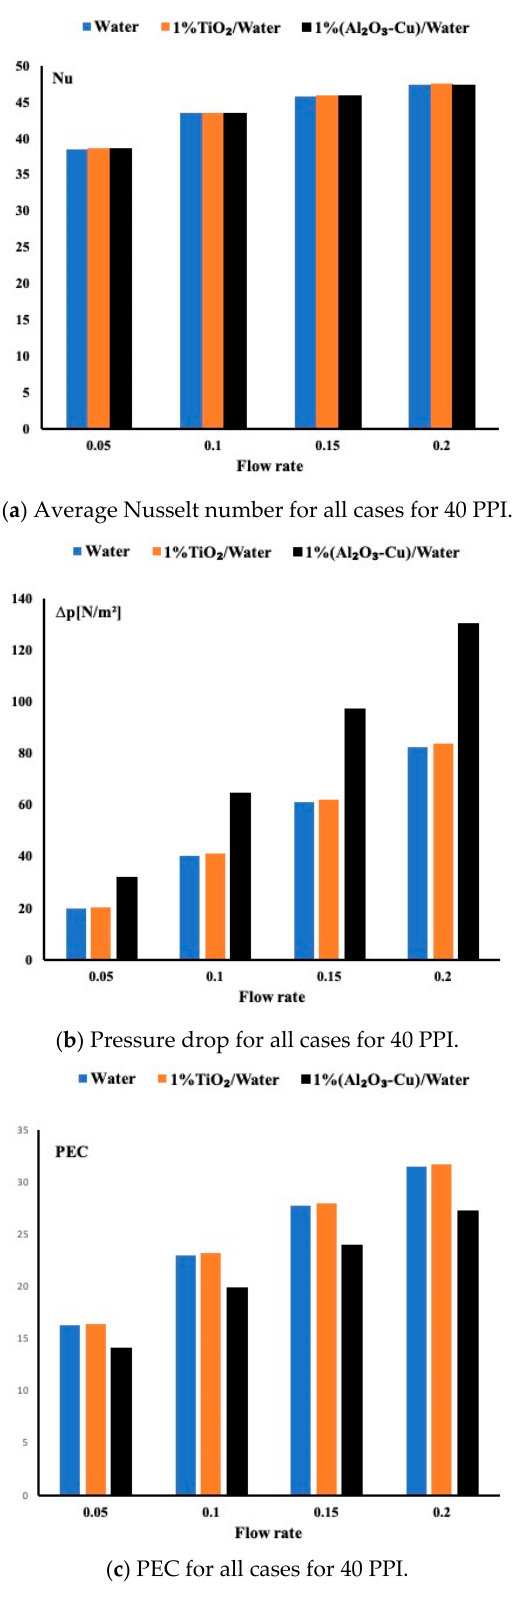
Figure 7. Average Nusselt number, pressure drop and PEC for all cases at a permeability of 40 PPI.